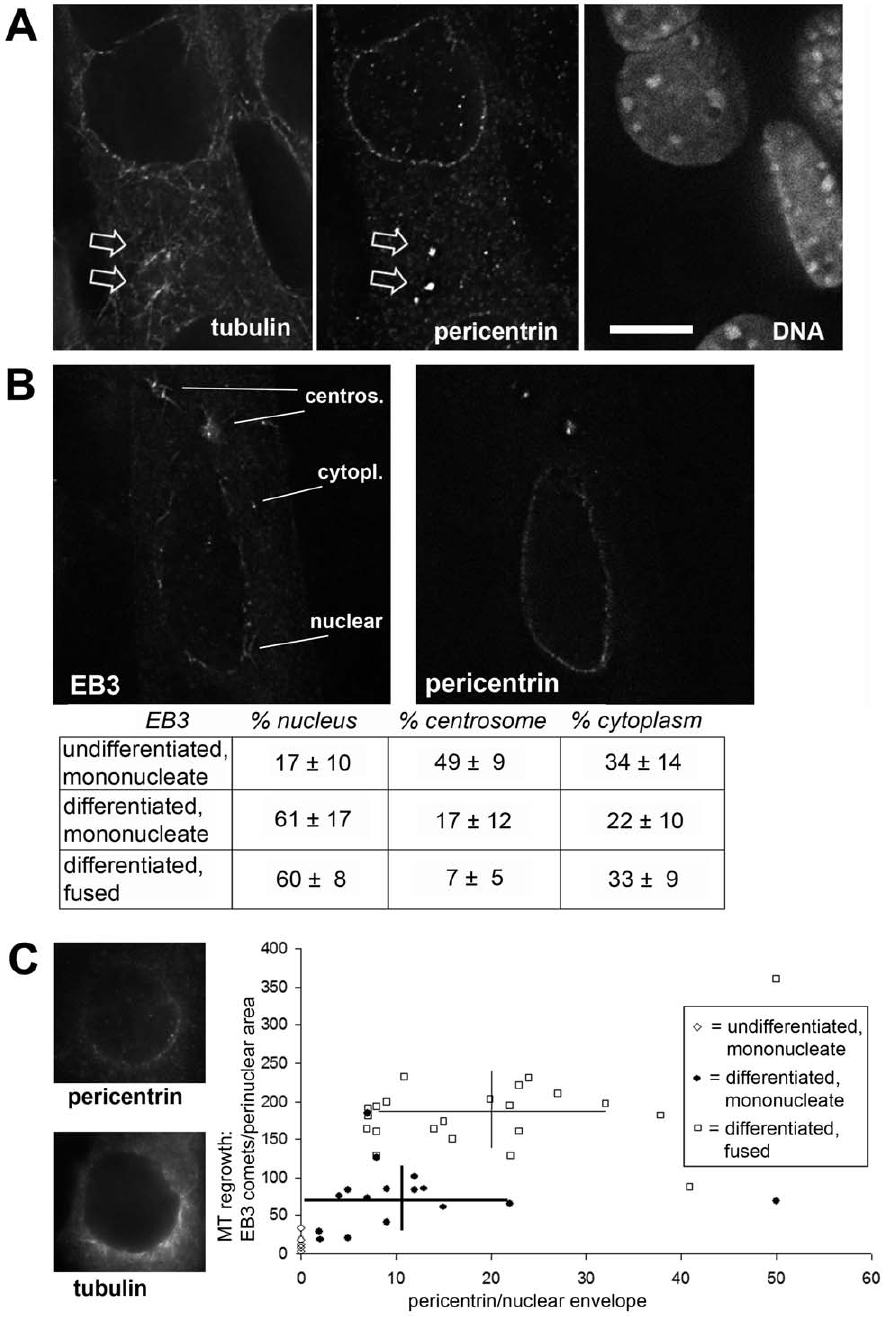
Figure 3. Microtubule nucleation from the centrosome is reduced in the differentiation process. (A) Deconvolved optical sections of differentiated muscle cells after re-growth of microtubules for 20 seconds, stained for immunofluorescence of (left) microtubules, (middle) the centrosome protein pericentrin, and (right) stained with the DNA marker DAPI. In a myotube early after fusion, pericentrin is visible both around the nuclear surface and on the centrosomes (arrows). Microtubule re-growth is seen from these centrosomes, in addition to perinuclear and cytoplasmic sites. (B) Myotube, after cold-induced depolymerization of microtubules and re-growth for 10 seconds. Immunofluorescence of the plus-end-binding protein EB3 and of pericentrin are shown. Cytoplasmic, nuclear, and centrosomal sites of emerging EB3 comets are indicated on the left. The table indicates the percentage of EB3 comets growing from cytoplasmic, nuclear, and centrosomal locations in undifferentiated cells (n=6), as well as in differentiating cells before fusion (mononucleate, n=15), and after fusion (n=12). The total number of EB3 comets per cell ranged from 39 (undifferentiated) to 1151 (differentiated, fused). (C) Left: nucleus of a myoblast at an early stage of differentiation, stained for pericentrin (top) and microtubules (bottom), recovering for 10 seconds from cold-induced depolymerization. The number of microtubules grown from the nuclear surface was quantified by counting EB3 comets as in (B). The results for each nucleus were plotted against the intensity of perinuclear pericentrin (arbitrary values, after subtraction of background) in undifferentiated cells (n=6), and in mononucleate (n=15) and fused differentiated cells (n=22). Horizontal and vertical bars indicate standard deviations of pericentrin intensity and of the number of EB3 comets, respectively, in differentiated mononucleate and fused cells. Bar in (A), 10 m m; identical magnification in (B), (C).